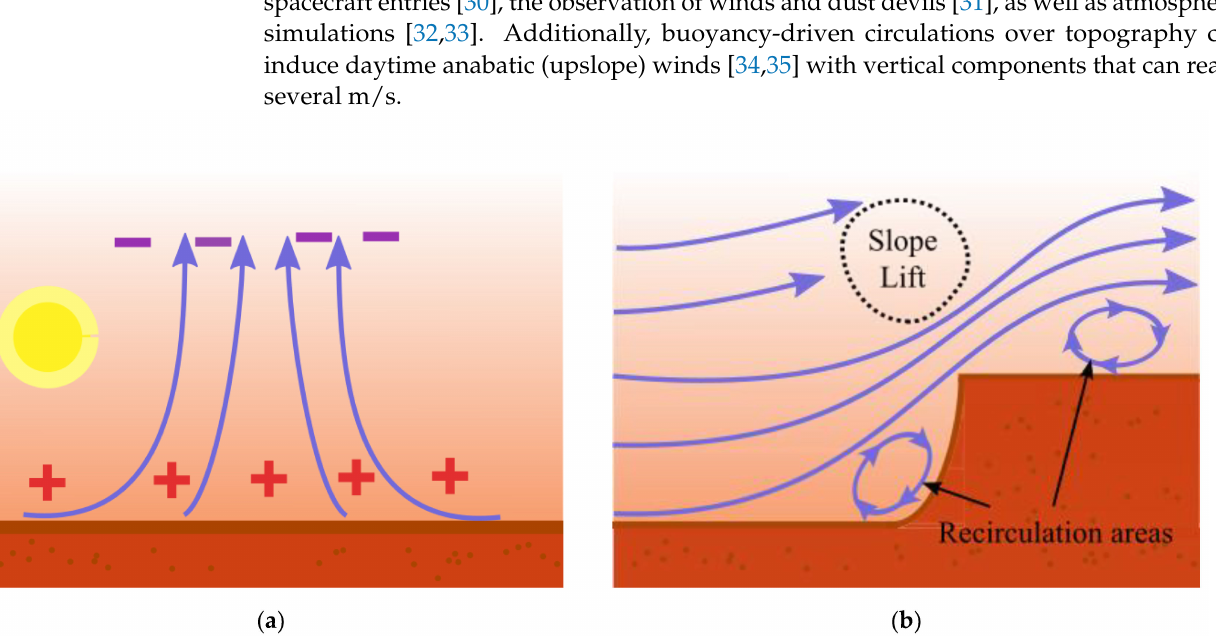
Figure 4. Atmospheric updrafts for static soaring: ( a ) thermals due to ground heating; ( b ) slope updrafts near